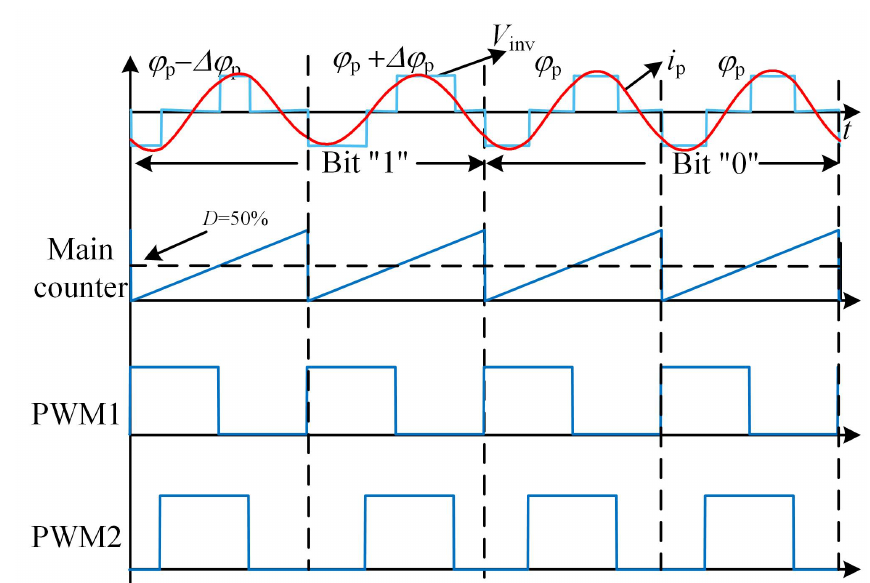
Figure 6. Key waveforms of full-bridge inverter and modulator during the modulation of bit “1” and bit “0”.